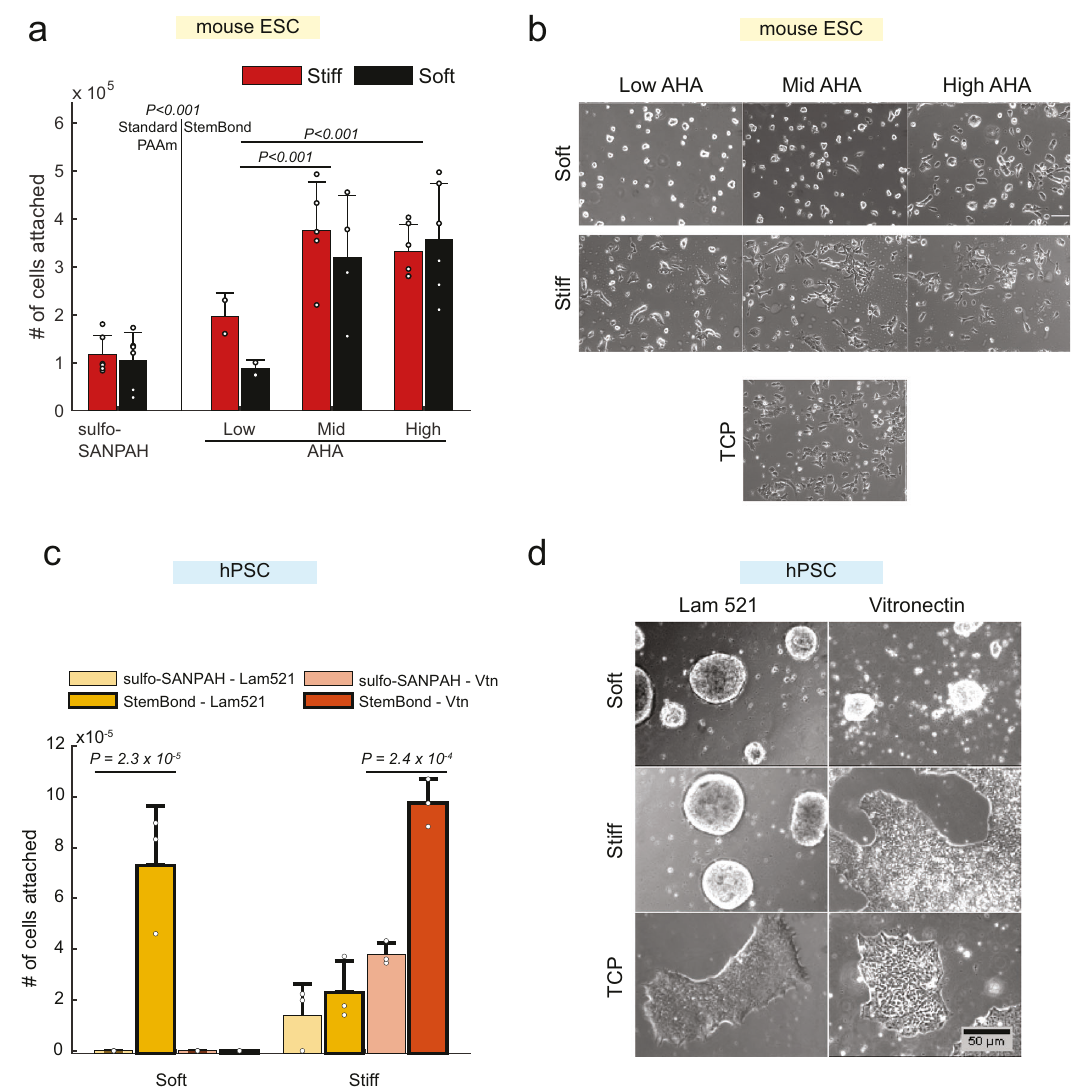
Fig. 2 StemBond improves cell attachment to soft hydrogels. a mESC attachment on sulfo-SANPAH functionalised standard PAAm hydrogels (left) and StemBond hydrogels (right). Cells were counted after 48 h in serum + LIF ( n = 2 – 6 independent samples). P -values from ANOVA with Tukey – Kramer ’ s multiple comparison test comparing Low AHA to Mid AHA and High AHA, and sulfo – SANPAH hydrogels to StemBond hydrogels globally. Stiffness was not a signi fi cant factor ( p = 0.58). Bars show mean ± standard deviation, points show the value independent samples. b Representative bright fi eld images of cells after 24 h in serum + LIF on tissue culture plastic (TCP), stiff and soft StemBond hydrogels with different adhesiveness (AHA concentrations). Scale bar: 100 µ m. c hPSC attachment on soft and stiff sulfo-SANPAH functionalised standard PAAm hydrogels and high AHA StemBond hydrogels, with laminin 521 or vitronectin coating. Cells were counted after 4 days in E8 media ( n = 3 independent experiments). P -values were computed using a one-way ANOVA with Tukey – Kramer ’ s multiple comparison test, comparing sulfo-SANPAH functionalised to StemBond hydrogels for each stiffness and ECM protein. On soft substrates, only Laminin on StemBond yielded enough cells, other conditions yielded very little cells, below the range of the cell counter. Error bars show standard deviation, points show the value independent repeats. d Representative bright fi eld images of hPSC colonies attached to laminin 521 and vitronectin coated StemBond hydrogels at day 4 of seeding (day 2 for TCP). Cells were grown in E8 media with ROCK inhibitor for the fi rst 24 h. Scale bar: 50 µ m. Source data are provided as a Source Data fi